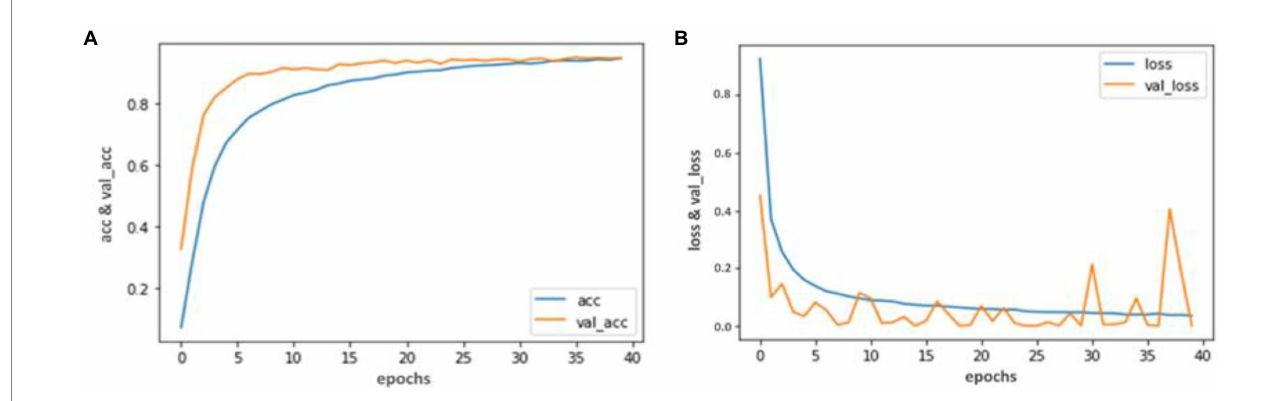
FIGURE 3 Accuracy and Loss graph using the YOLO V3. (A) Representing the training and Validation accuracy while (B) representing the training and validation loss of YOLO V3 model according to our dataset.